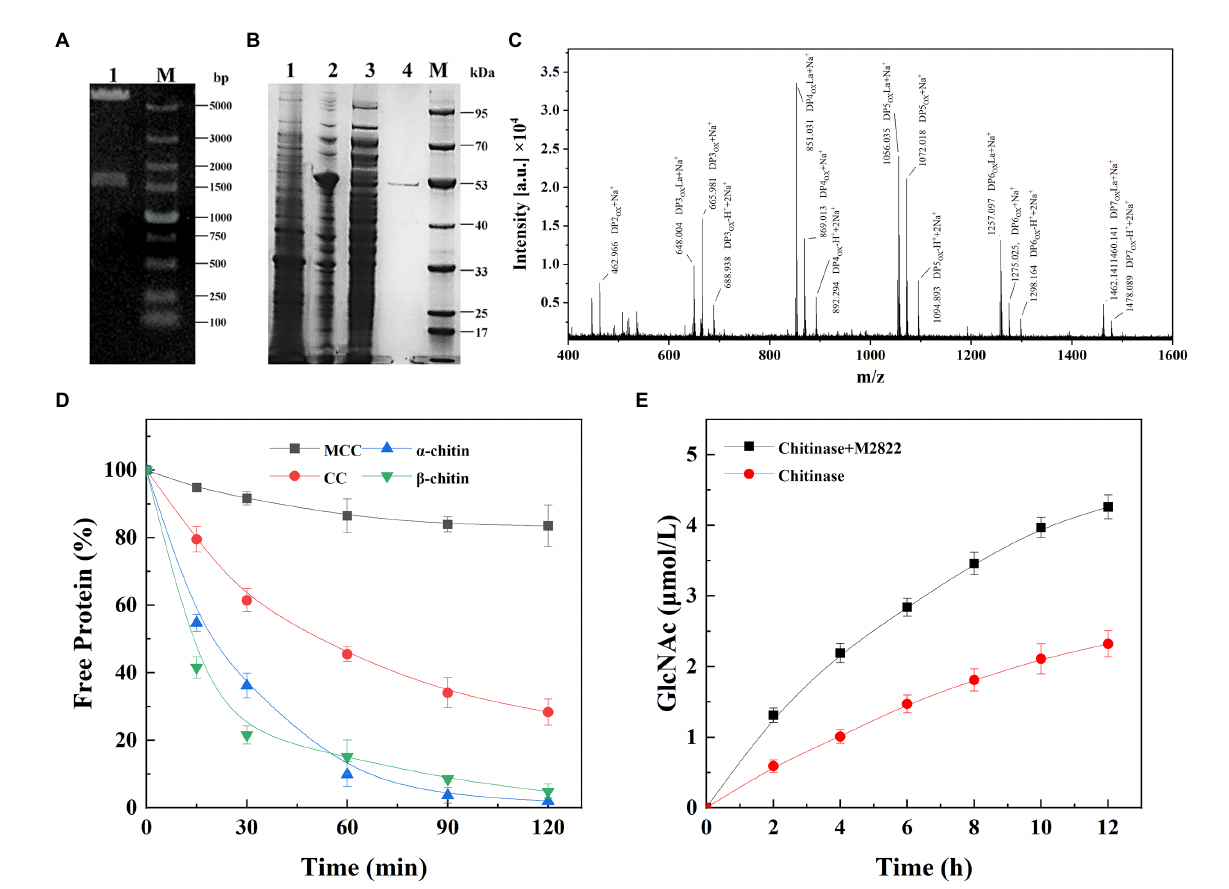
FIGURE 4 Expression, purification and activity assay of M2822. (A) Verification of M2822 gene expression plasmid by nucleic acid electrophoresis. Lane 1, pET- 22b-m2822 XhoI and NdeI double enzyme digestion; lane M, DNA marker; (B) SDS-PAGE analysis of purification process of M2822. lane 1, contains no plasmid-expressed E. coli BL21 protein; lane 2, E. coli BL21-M2822 soluble protein; lane 3, E. coli BL21-M2822 global protein; lane 4, purified M2822 protein; Lane M, protein marker; (C) MALDI-TOF MS analysis of the products generated by M2822; (D) Adsorption capacity of different substrates to M2822; (E) Synergistic degradation of chitin by the M2822 with commercial